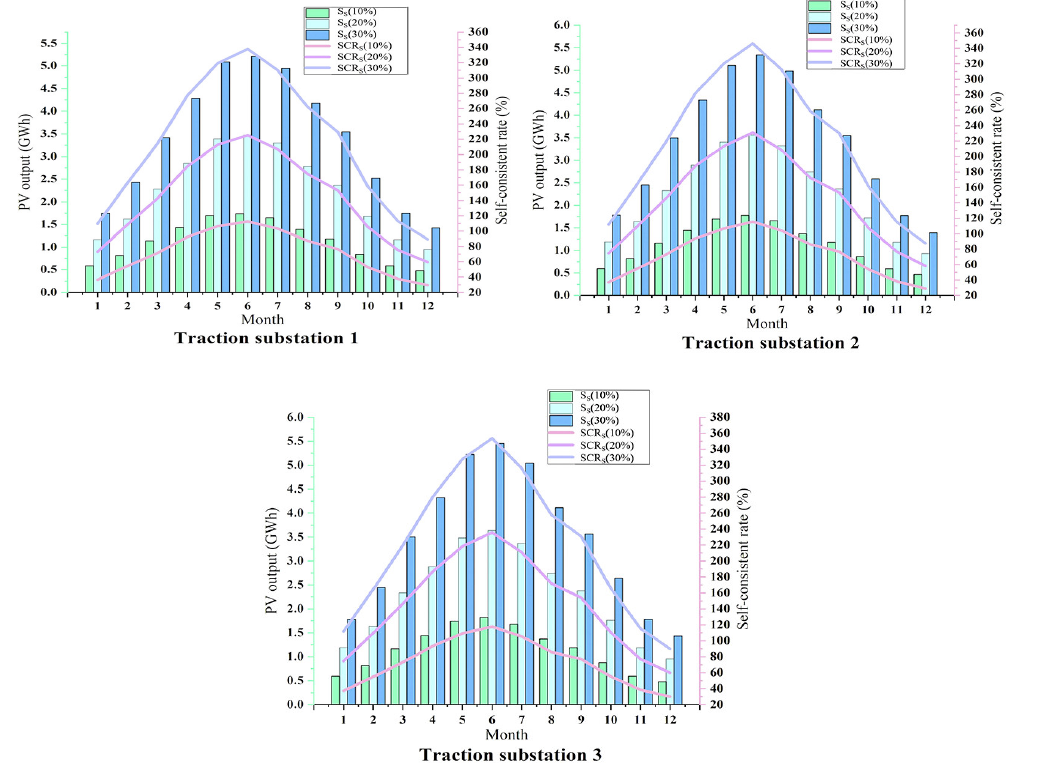
Figure 8. Monthly measurement results in different traction substation. Table 2. Annual load, photovoltaic output, and self-consistency rate of the measured traction substation.